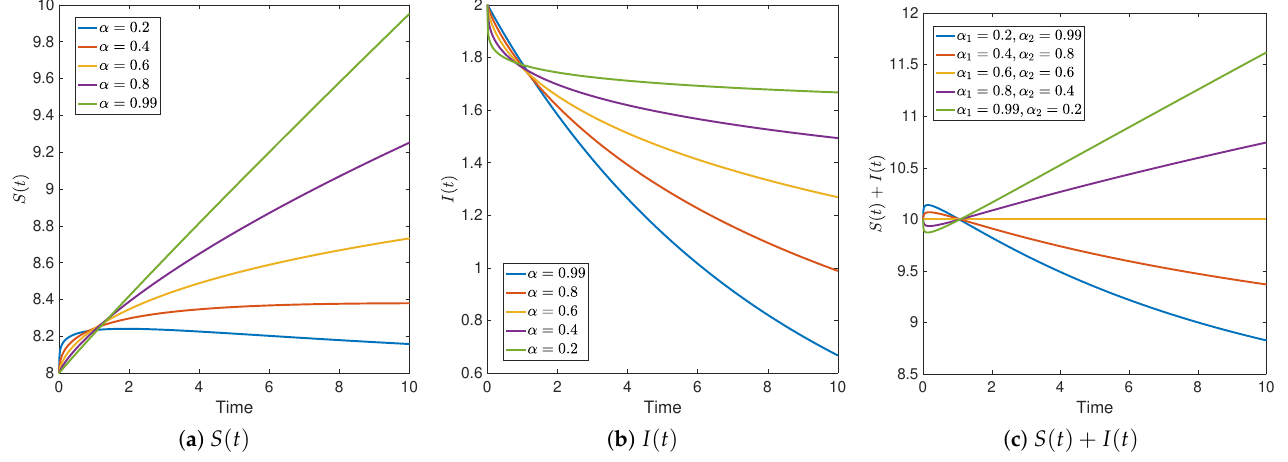
Figure 2. Numerical solutions to (1) with β = 0.1, γ = 0.2, I 0 = 8 and S 0 =